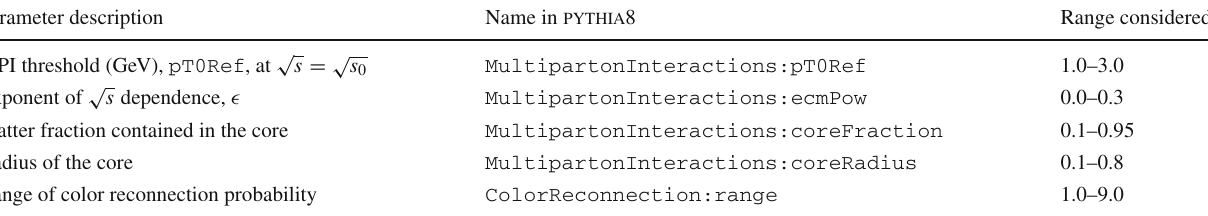
Table 1 Parameters in the pythia 8 MC event generator together with the PDFs determine the energy dependence of MPI, the overlap matter distribution function, and the amount of simulated color reconnection. The parameter ranges used for the fits are also listed Parameter